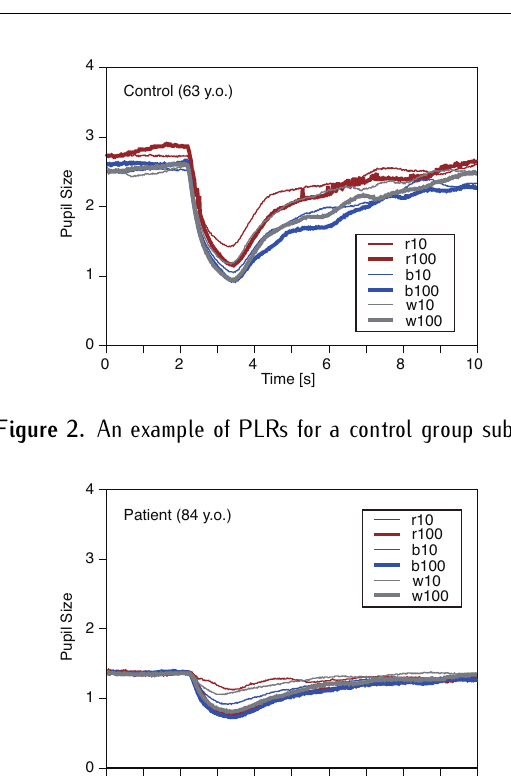
Figure 3. An example of PLRs for an AD patient